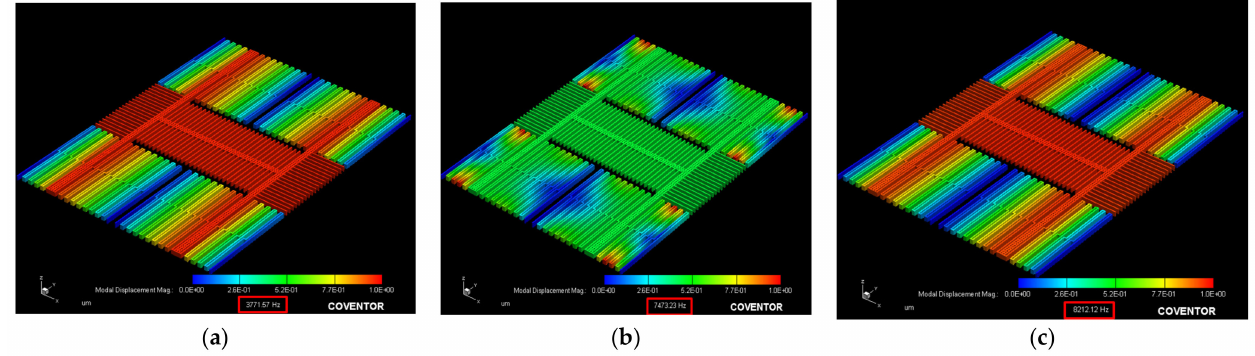
Figure 4. Modal analysis for the accelerometer movement along the ( a ) X -, ( b ) Y -, and ( c ) Z -axes. By the shift of the X / Y / Z axes modal analysis, we can ensure the direction of the design current and make the structure move in the correct corresponding modal. The MAG’s plane motion direction along the X / Y / Z axes are shown in Figure 5a–c.